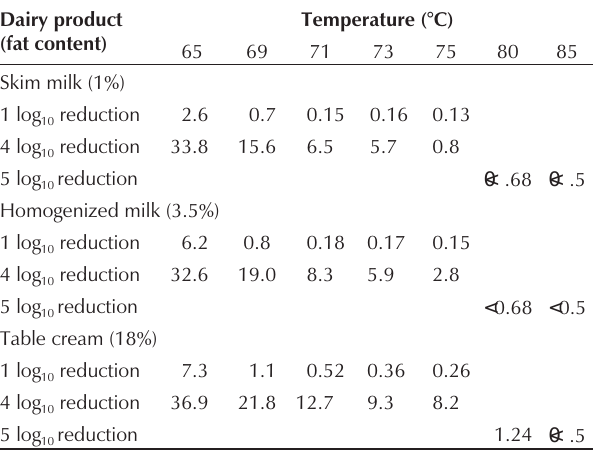
Time (mins) required for various levels of log 10 in the infectivity of hepatitis A virus when dairy products with differing fat